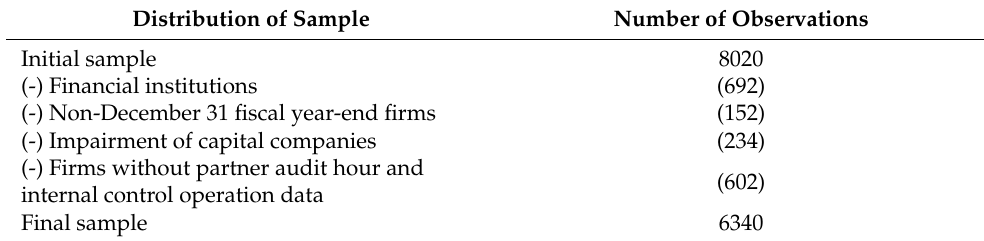
Table 1. Sample selection.